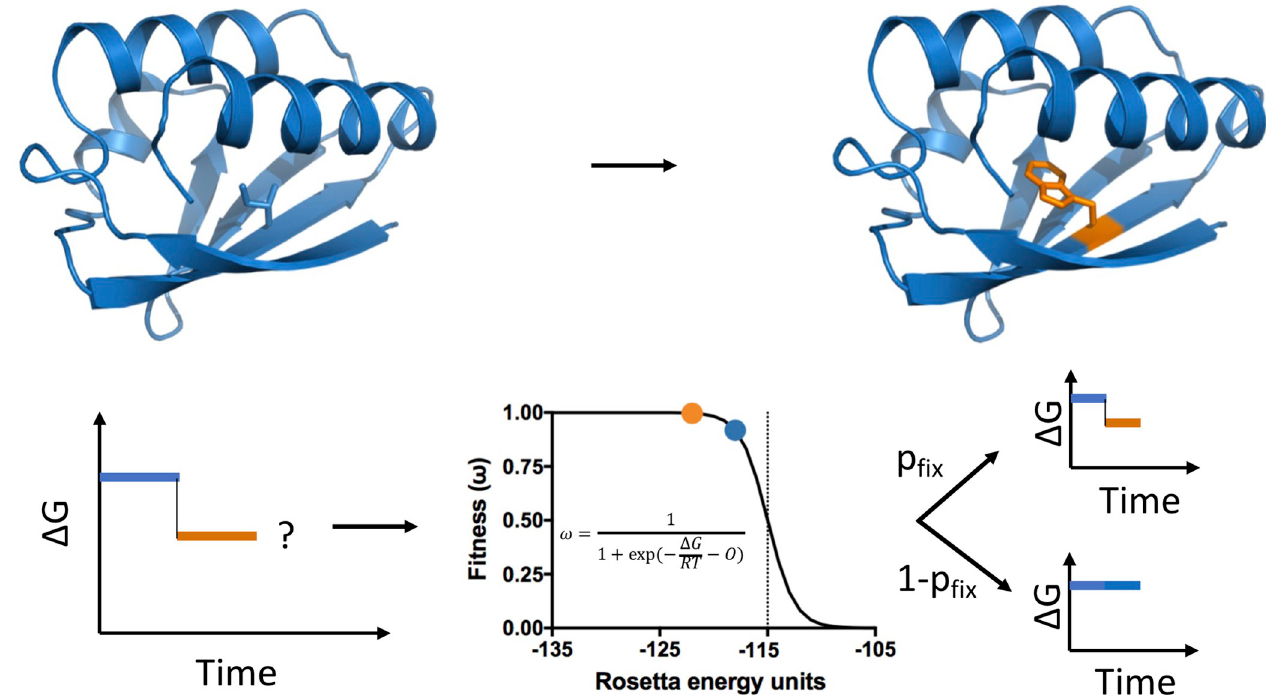
Fig 1. Simulation of evolutionary trajectories with RosettaEvolve. Mutations are proposed at the nucleotide level and nucleotide changes are translated into amino acid substitutions. The fitness of a mutation is estimated by calculating the change in stability of the protein with a ΔΔ G prediction method using the Rosetta all-atom energy function. Based on the change in fitness (selection coefficient) the probability of fixating the proposed nucleotide/amino acid is evaluated.